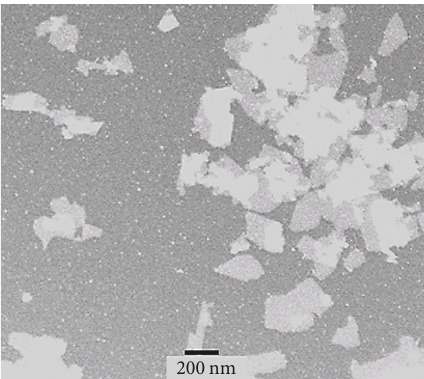
Figure 1: TEM image of exfoliated pure Na-montmorillonite after mechanically stirring in deionized (DI) water for 24–48 hours to break apart the stacking of the